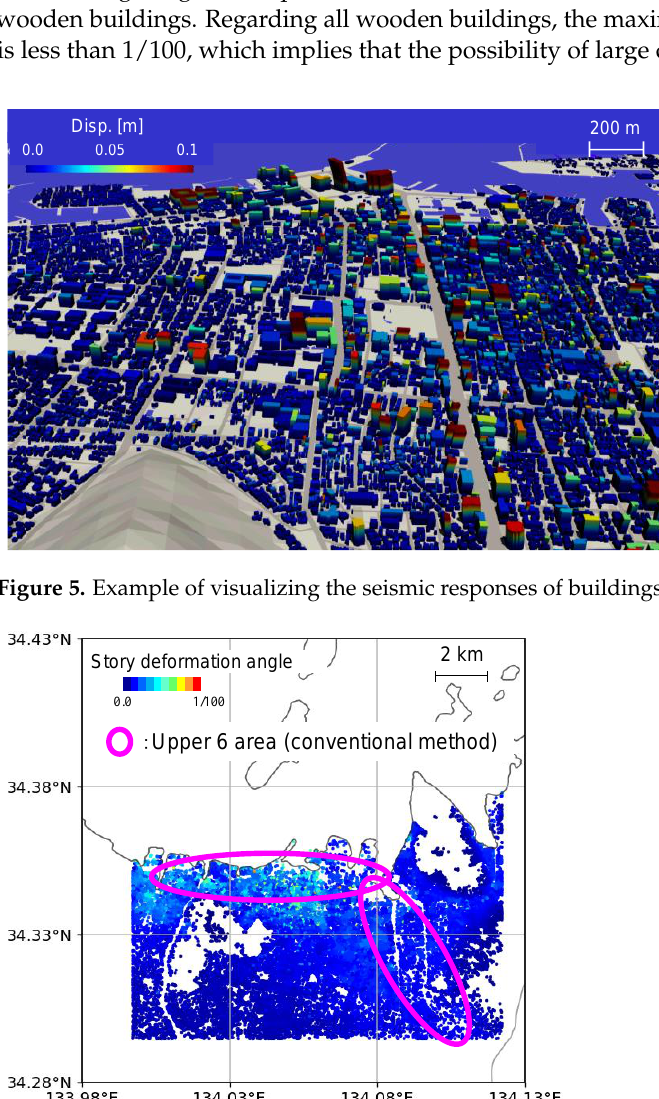
Table 1. Parameters of subsurface soil models by the soil classification.